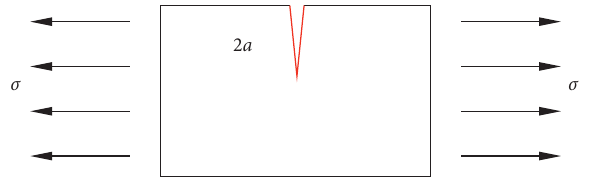
Figure 6: Stress analysis diagram of edge crack. Table 1: Parameters of